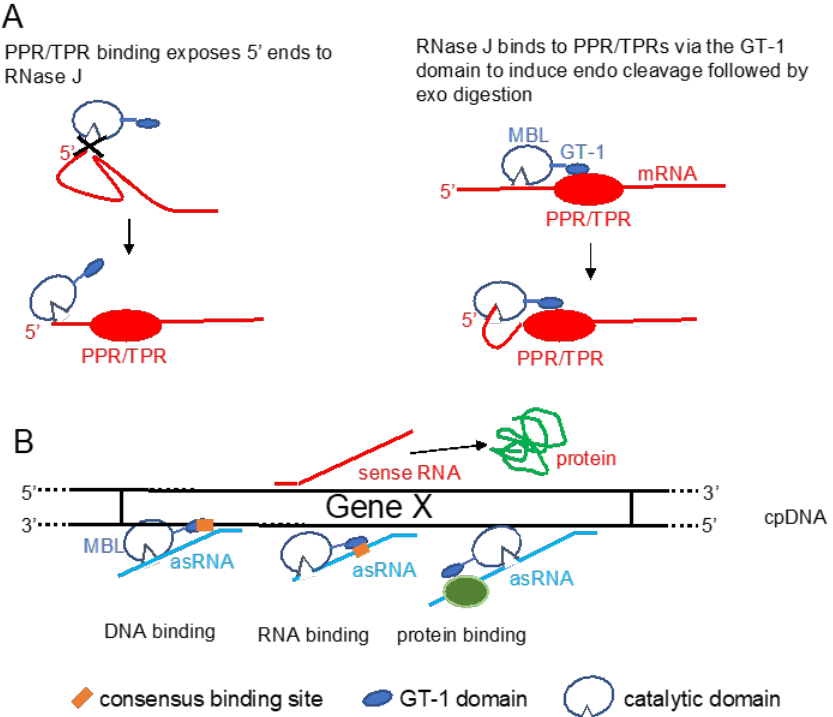
Figure3. PutativefunctionsoftheGT-1domaininmodelsforRNaseJmodesofaction. ( A )Twoscenarios for chloroplast (cp) 5 (cid:48) -end maturation by RNase J and the corresponding RNA-binding protein (RBP). Left , the RNA 5 (cid:48) -end structure prevents RNase J access. Binding of the RBP induces a structural change, exposing the 5 (cid:48) end to digestion. Right , RNase J is recruited to the 5 (cid:48) end by direct binding to the RBP, perhaps via the GT-1 domain. ( B ) Possible mechanisms of GT-1 domain-mediated recruitment of RNase J to targeted asRNAs by binding to a DNA site near the asRNA transcription start ( left ), to the asRNA itself ( center ), or to an RNA-binding cofactor ( right ). PPR / TPR: pentatricopeptide / tetratricopeptide repeat-containing